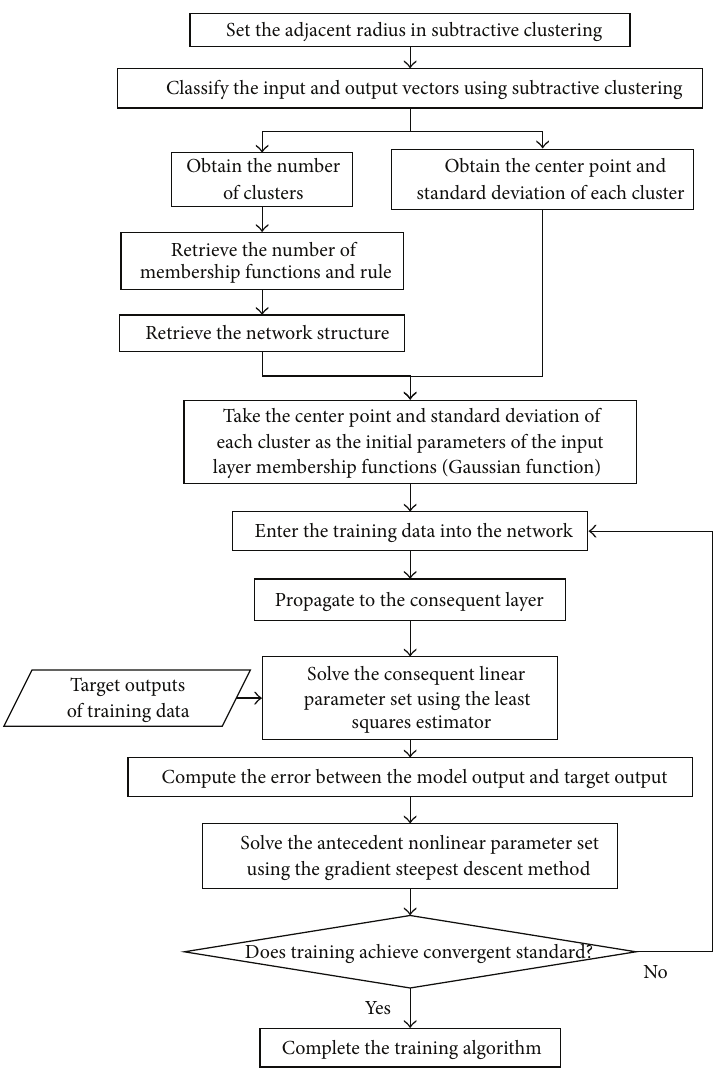
Figure 4: Flowchart of training the optimal parameters and structure of ANFIS by combining subtractive clustering, least squares estimator, and gradient steepest descent